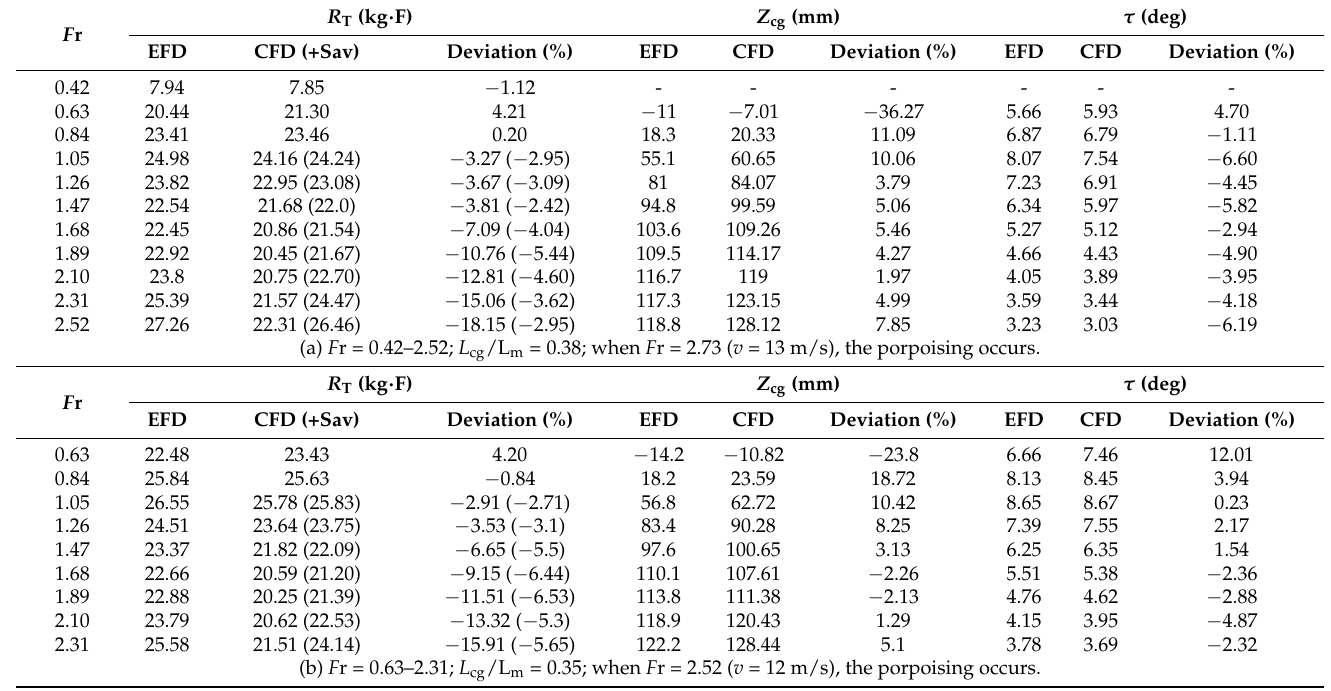
Table 7. The comparisons of total resistance ( R T ), sinkage ( Z cg ), and trim angle ( τ